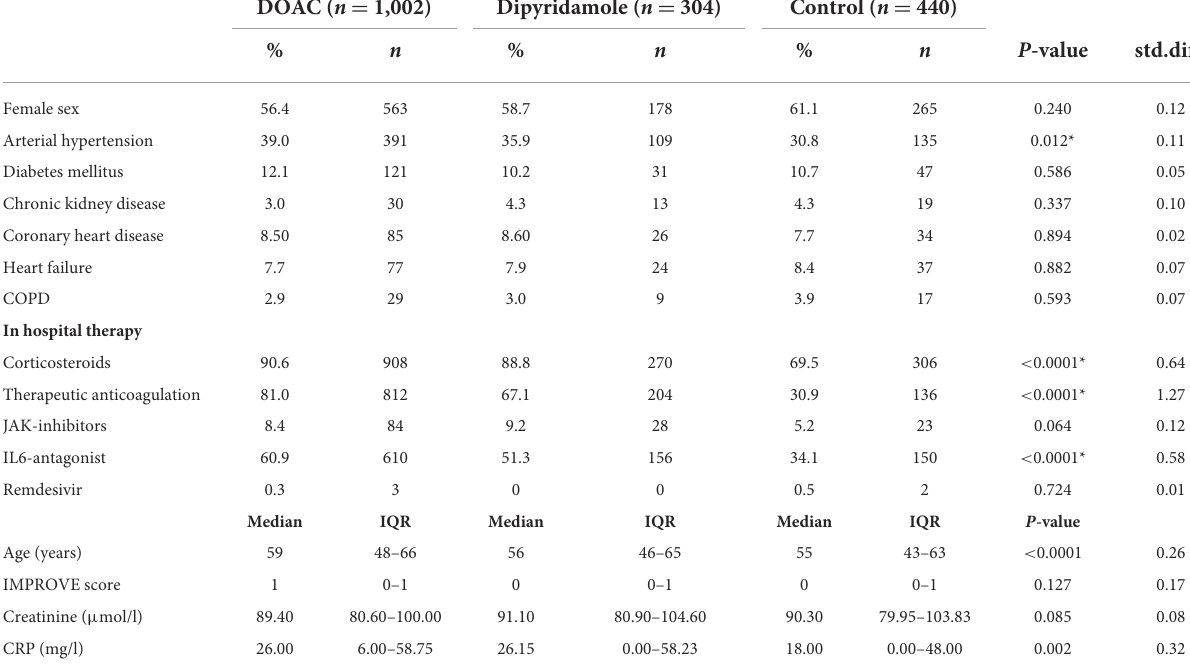
TABLE 1 Baseline characteristics of enrolled